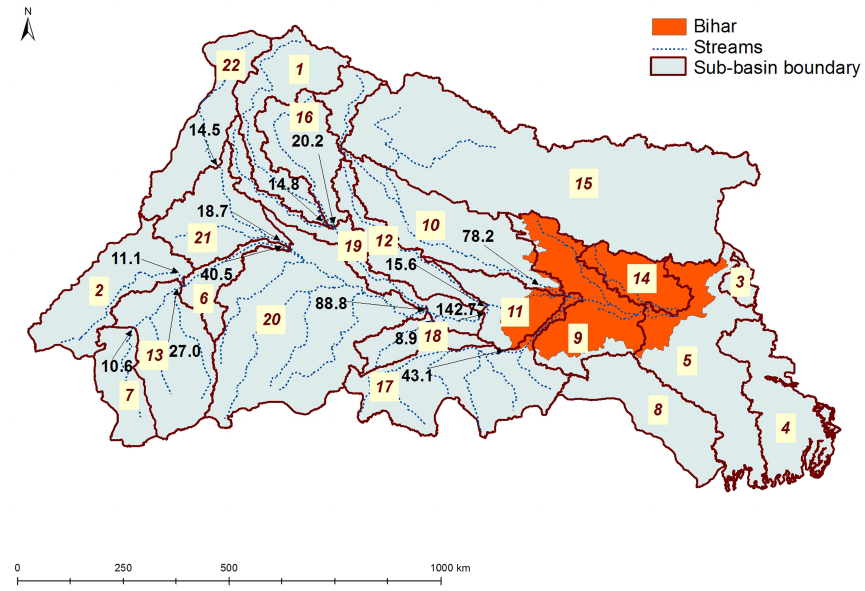
Figure 4. Mean annual outflow (billionm 3 ) from the sub-basins in the Ganges River basin (the numbers in black represent the mean annual outflow, and the numbers in brown in the yellow background represent the numbers of the